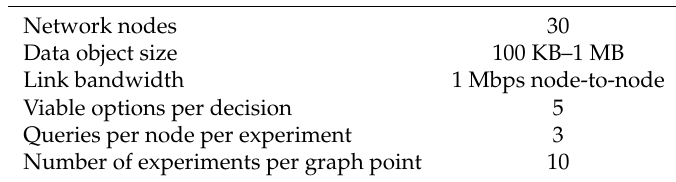
Table 1. Key emulation parameter settings (unless individual experiments state